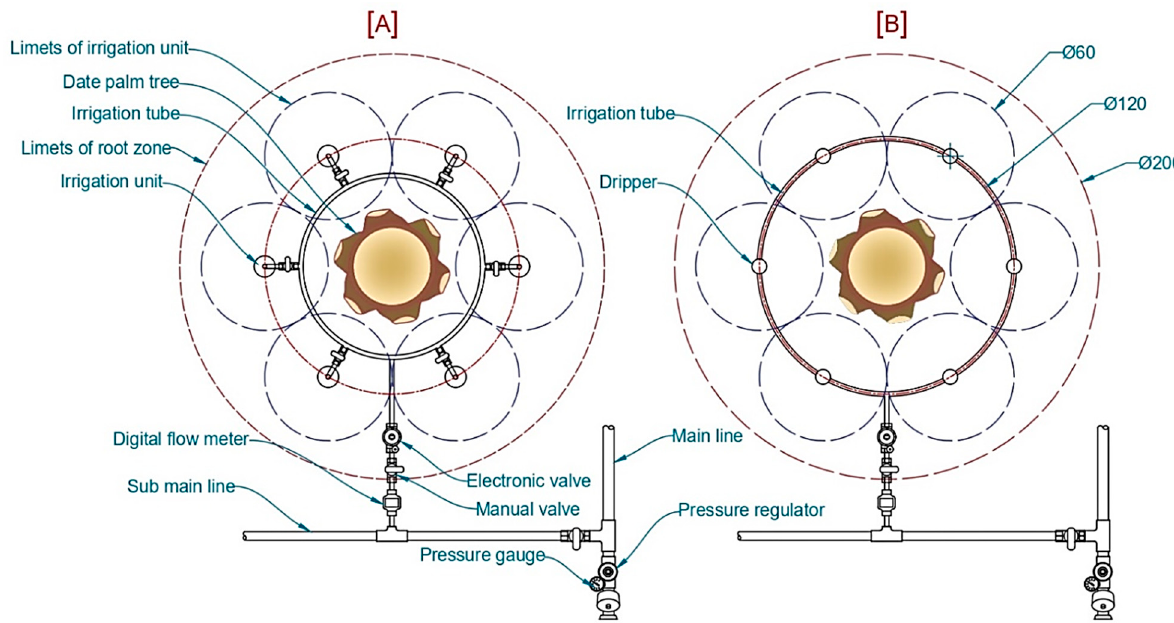
Figure 4. The main components of the surface irrigation system ( A ) and drip irrigation system ( B ). All dimensions are in centimeters.